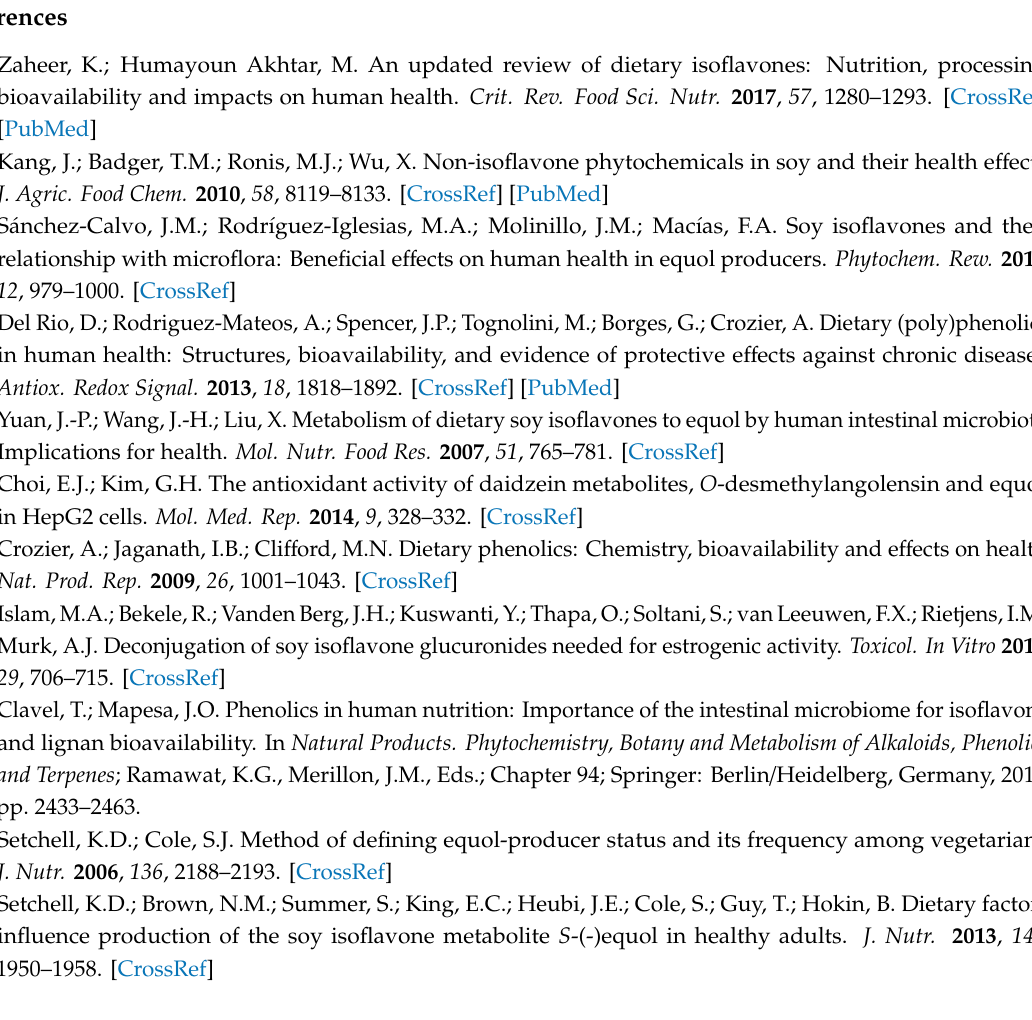
Figure S1: Dendogram of similarity of the combined typing profiles obtained with primers OPA18, M13, and BoxA2R expressed by the Simple Matching (SM) coe ffi cient. Clustering was performed by the unweighted pair group method using arithmetic averages (UPGMA). The dotted line indicates the repeatability of the combined typing method